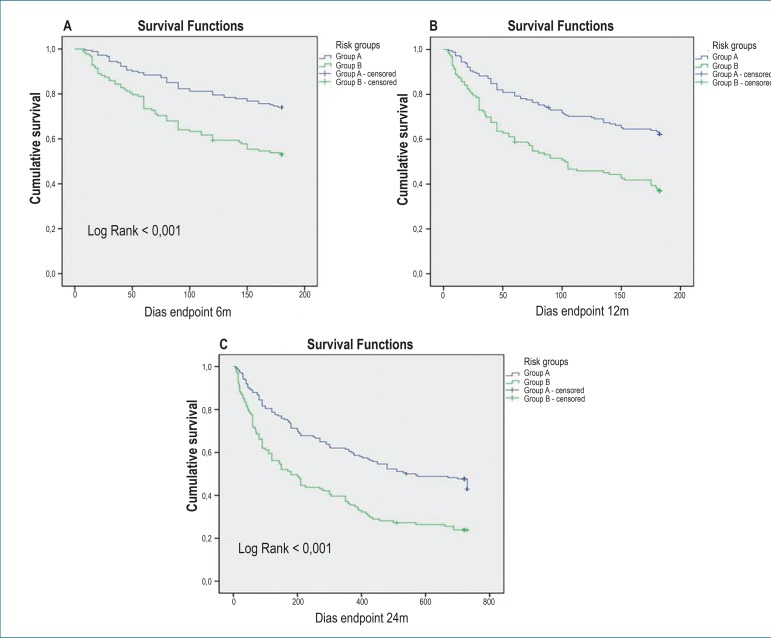
Kaplan Meier curves showing the rate of combined endpoint (mortality
and/or rehospitalization) of group A (score < 4) and group B
(score > 4) at 6 (A), 12 (B) and 24 months (C) of clinical
follow-up.